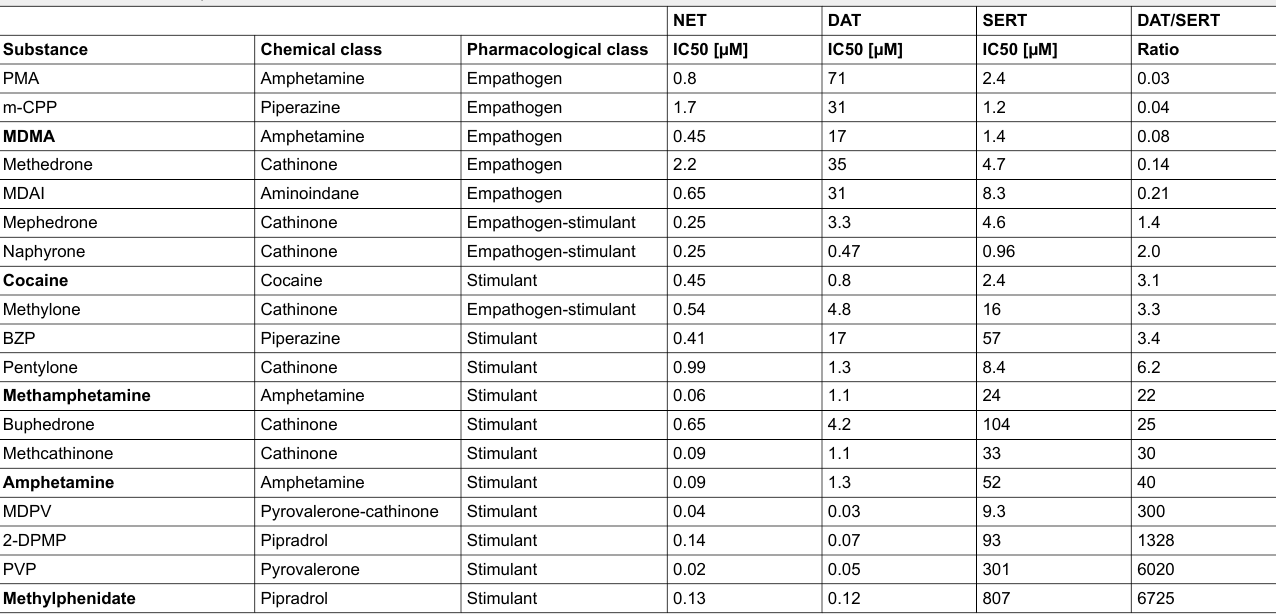
Table 1: Monoamine transporter